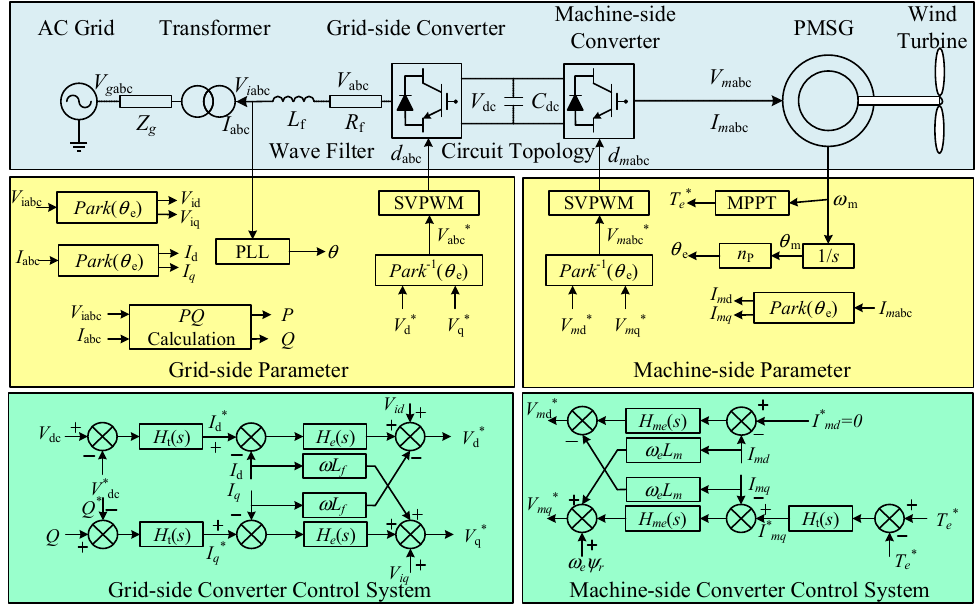
Figure 2. The inner and outer control loop of PMSG.